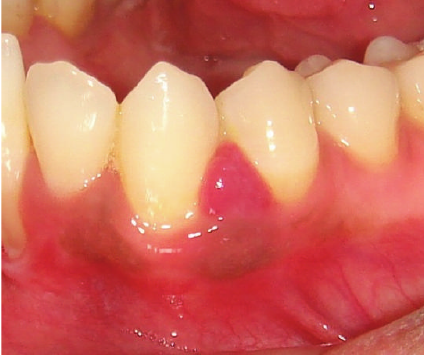
Figure 4: Size of the lesion after 7 days of nonsurgical treatment.